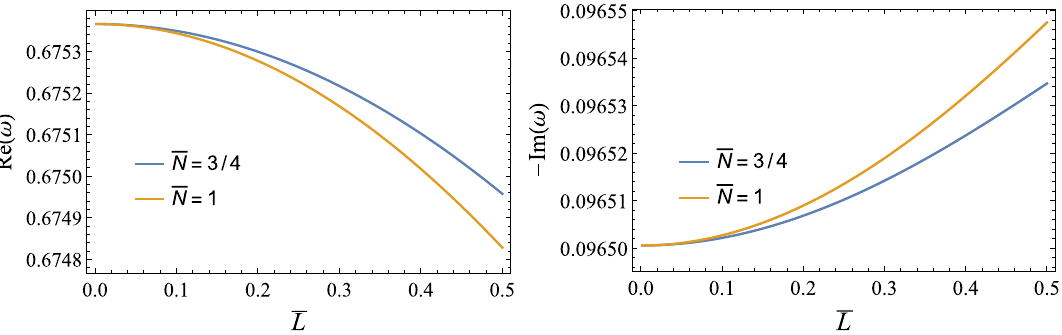
Fig. 17 QNMs of CRSBHs with respect to ¯ L , where l = 3 and n = 0 are set. The left diagram represents the real parts of ω with respect to ¯ L for the cases of ¯ N = 3 / 4 and ¯ N = 1, respectively; the right diagram